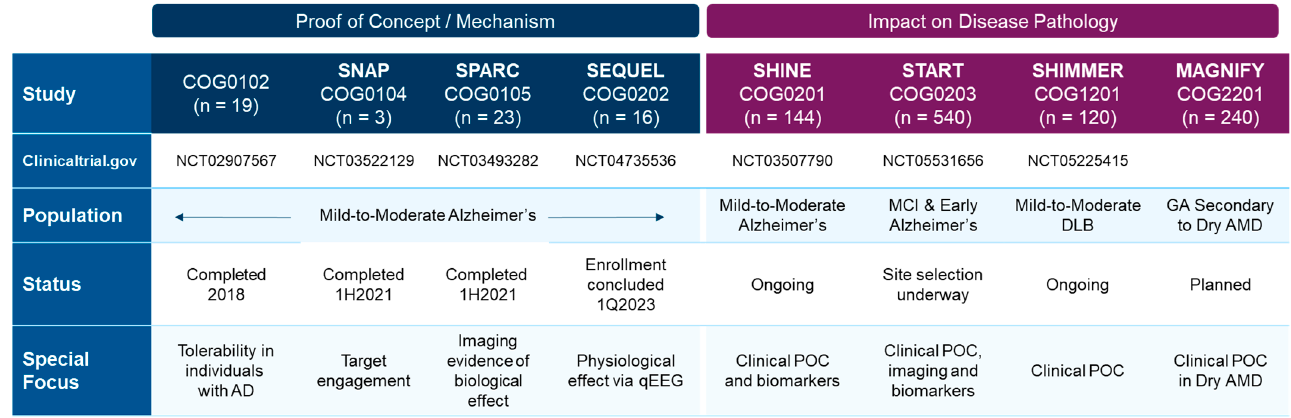
Figure 6. Completed and ongoing or planned clinical trials with the S2R modulator CT1812 in Alz- heimer’s disease, dementia with Lewy bodies (DLB), and dry AMD